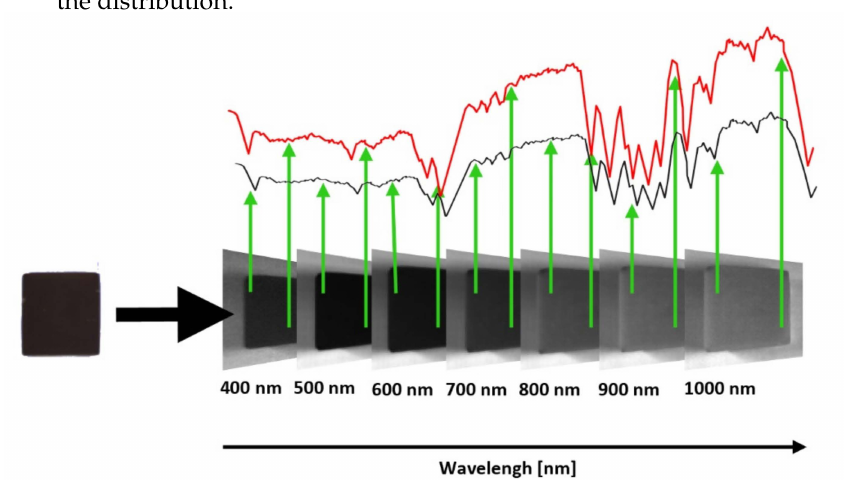
Figure 4. The idea of using hyperspectral imaging to assess the homogeneity of the distribution of chocolate ingredients.